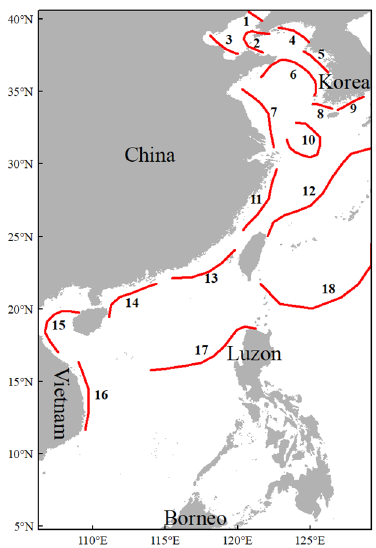
Figure 1. SST fronts in OC. The red line indicates the approximate position of the center line of the fronts. The names of fronts are: 1. Liaodong Bay Front (LDBF); 2. Bohai Front (BHF); 3. Bohai-Lai- zhou Bay Front (BLBF); 4. Seohan Bay Front (SBF); 5. Kyunggi Bay Front (KBF); 6. Yellow Sea Ring Front (YSRF); 7. Jiangsu Front (JSF); 8. Western Chejudo Front (WCF); 9. Eastern Chejudo Front (ECF); 10. Yangtze Bank Ring Front (YBRF); 11. Zhejiang-Fujian Front (ZFF); 12. Kuroshio Front (KF); 13. Taiwan Strait Front (TWSF); 14. South China Coastal Front (SCCF); 15. Bakbo Bay Front (BBF); 16. Vietnam Front (VF); 17. Luzon Front (LF); 18. Pacific Ocean east Of Taiwan Front